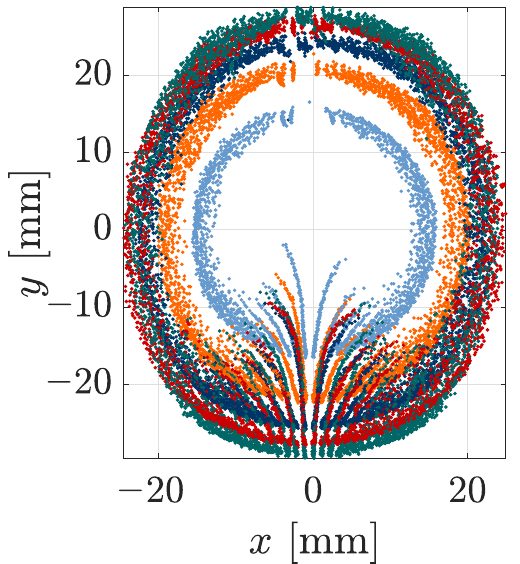
Figure 14. Reconstructed contact points based on the data from all 135 scanning sweeps (object distance: 25 mm in green, 30 mm in red, 35 mm in dark blue, 40 mm in orange and 45 mm in